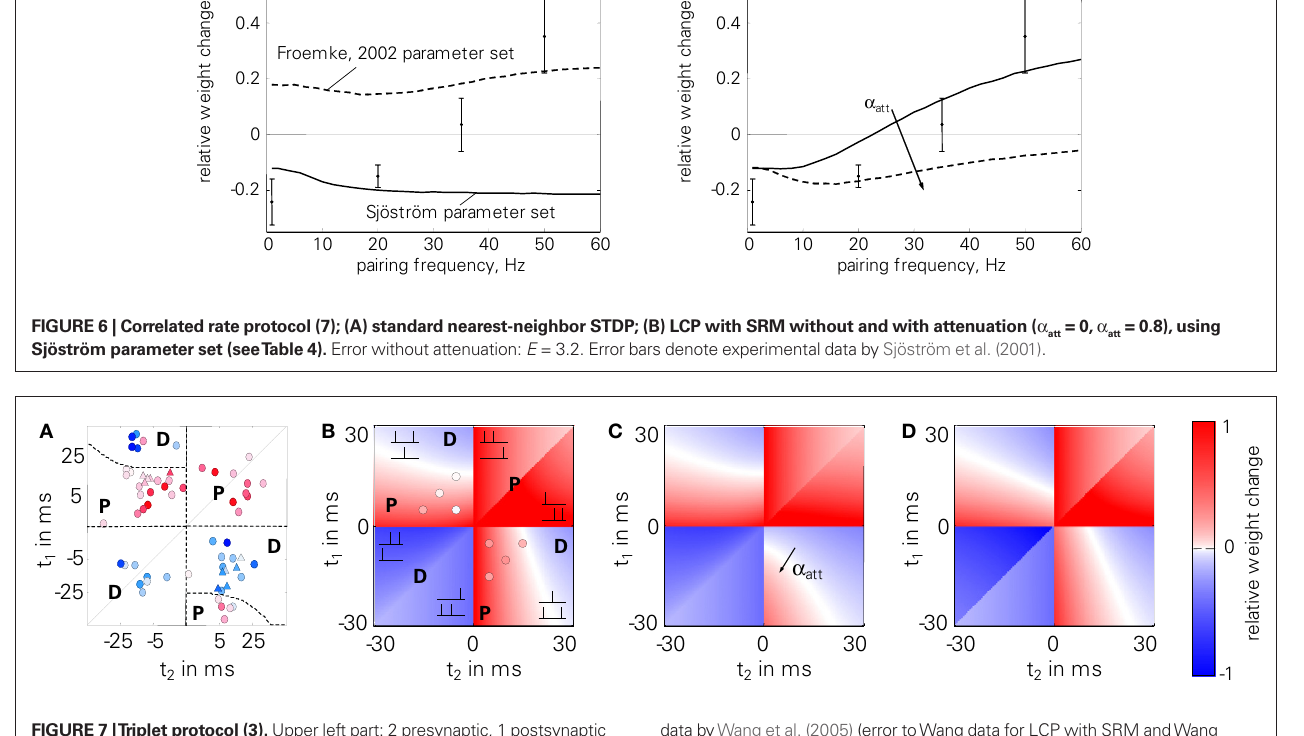
FigurE 7 | Triplet protocol (3). Upper left part: 2 presynaptic, 1 postsynaptic spike; lower right part: 1 presynaptic, 2 postsynaptic spikes; (A) experimental data of Froemke and Dan (2002); (B) LCP with SRM, using parameters from Froemke and Dan (2002), as listed in Table 4 (Froemke 1 parameter set); circles: